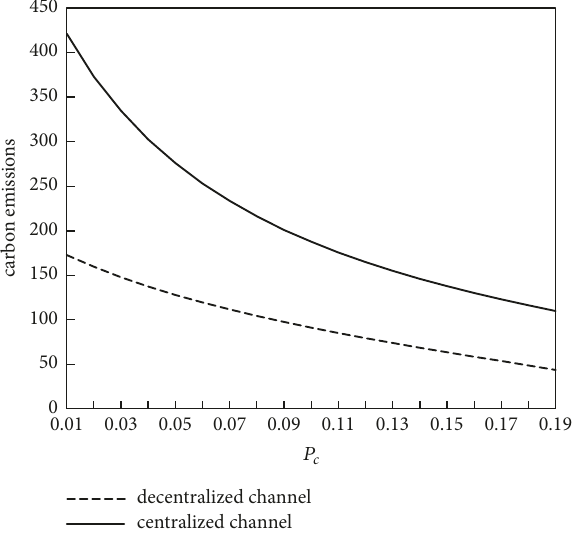
Figure 3: Order quantities under different carbon prices.